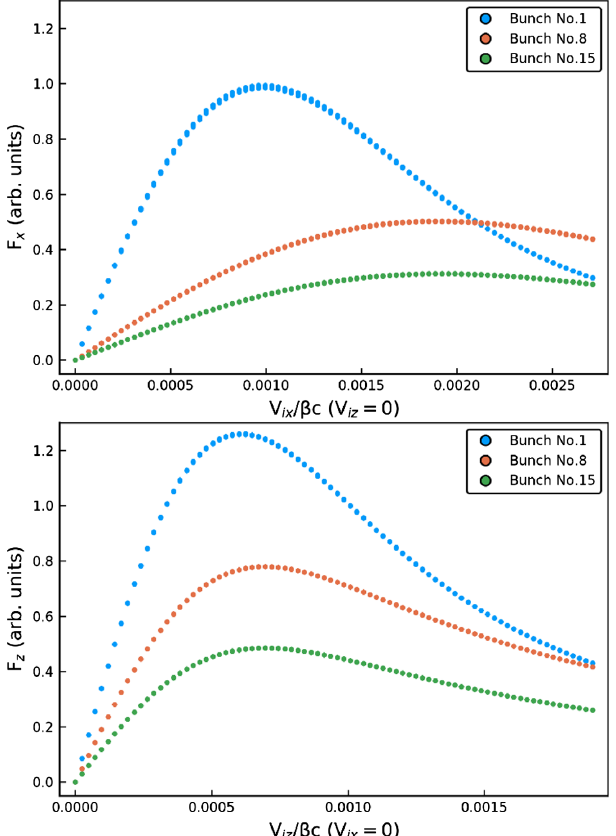
FIG. 6. Comparison of the cooling force for the electron bunches No. 1, 8, and 15 at the end of the CS of the yellow ring. Top: Transverse force. Bottom: Longitudinal